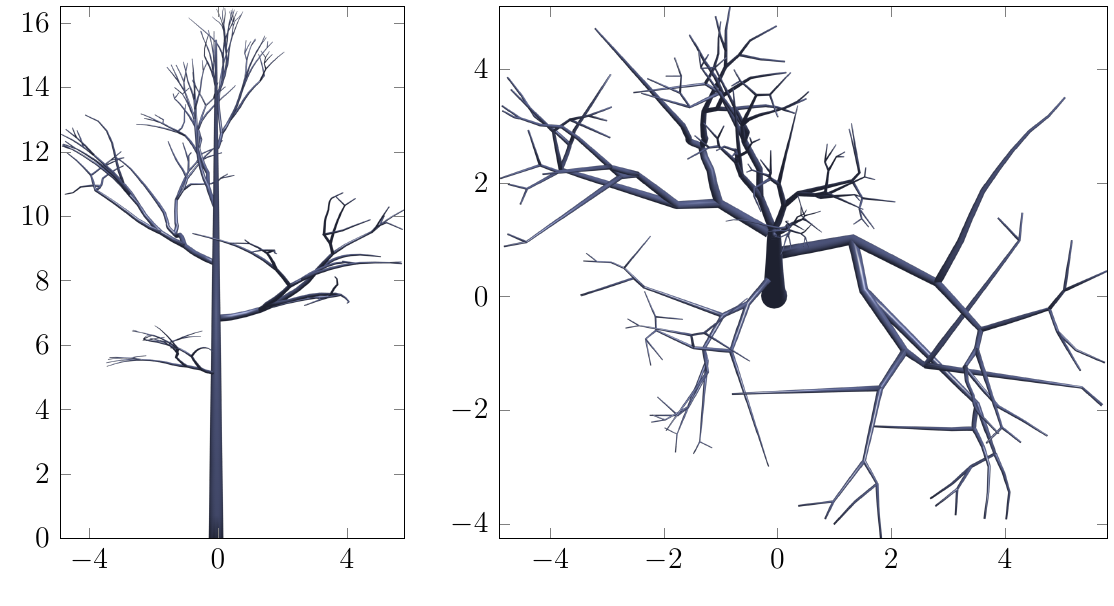
Figure 14. Generated tree model. ( Left ) Front view; ( right ) top view.